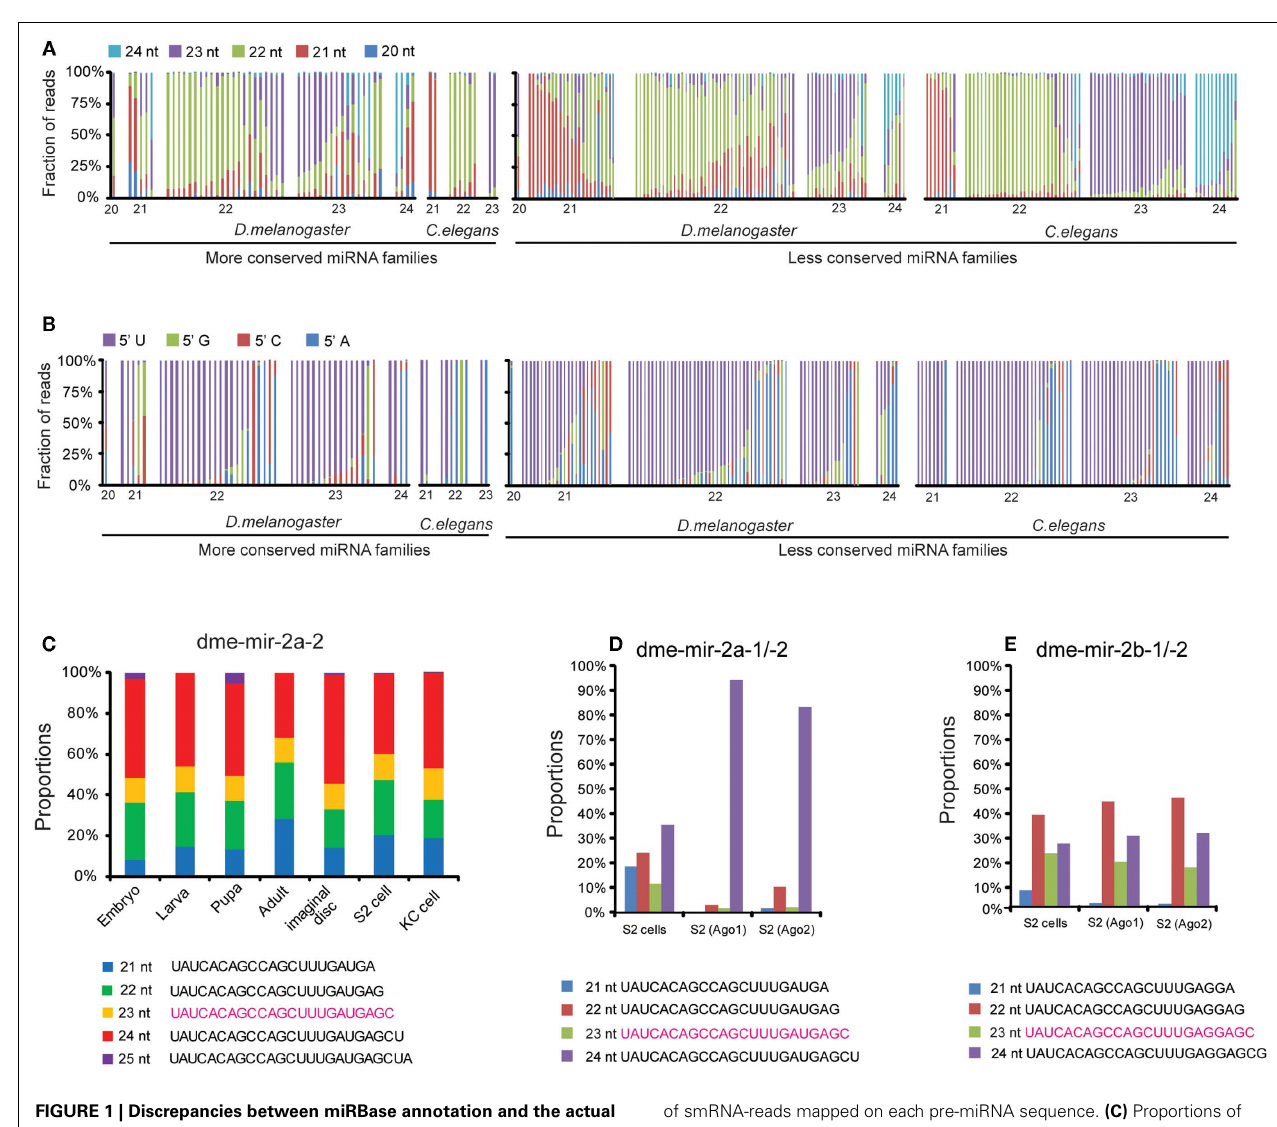
of smRNA-reads mapped on each pre-miRNA sequence. (C) Proportions of five dme-mir-2a-2 miRNA isoform sequences were consistent in different developmental stages. (D) The 24-nt dme-mir-2a is the preferential isoform associated with Ago proteins. (E) The 22-nt dme-mir-2b is the preferential isoform associated with Ago